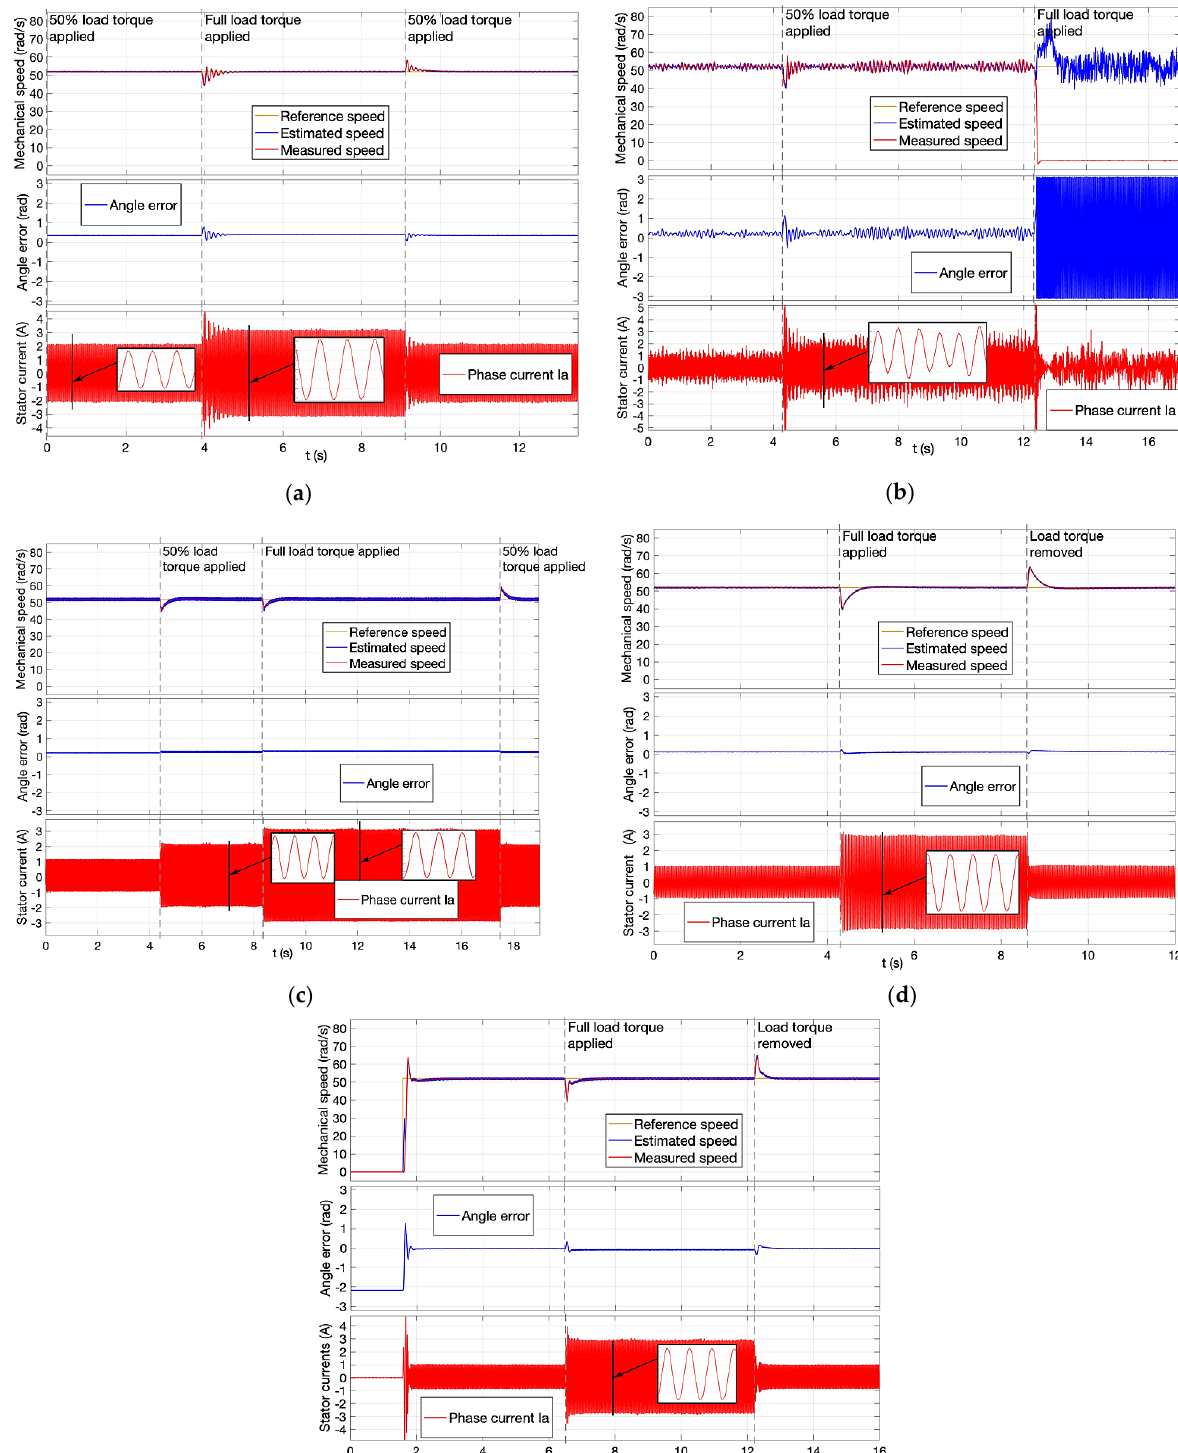
Figure 14. Speed, estimated angle error and stator current after the appliance of load torque steps: ( a ) ELADRC algorithm; ( b ) FACCF-SMO algorithm; ( c ) nonlinear RFO; ( d ) adaptive RFO; ( e ) regres- sion RFO.